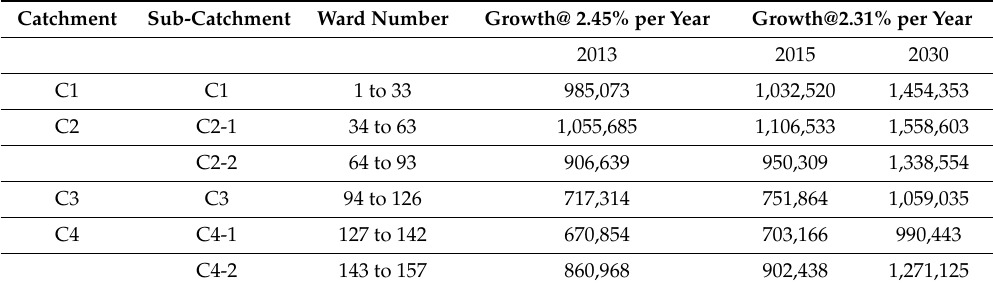
Figure 4. Schematic diagram highlighting the problem domain for modelling Adyar River water quality modeling using WEAP interfaces ( a ) for current year 2015 and ( b ) for future year 2030. Table 1. Summary of population distribution for catchments and sub-catchments considered for the simulation.